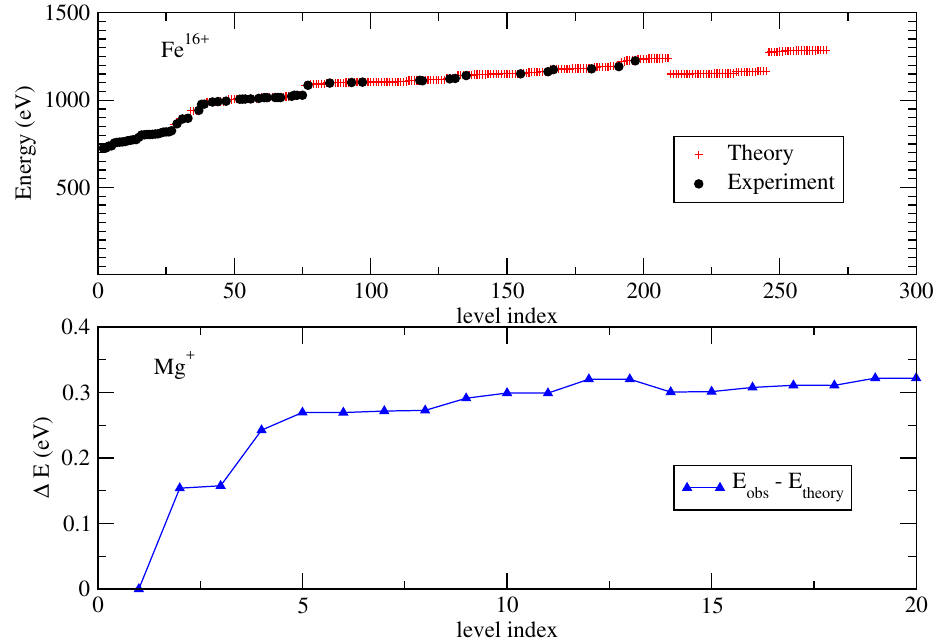
Figure 3. Theoretical and experimental energies for levels obtained from the CHIANTI (v7, [88]) database. ( Top ) Fe 16 + : Observed energy levels (up to n = 5): [89]; observed energy levels (n = 6,7) from the wavelength measurements of [90]. ( Bottom ) Mg + : theoretical energies: [78]; observed energies from NIST: